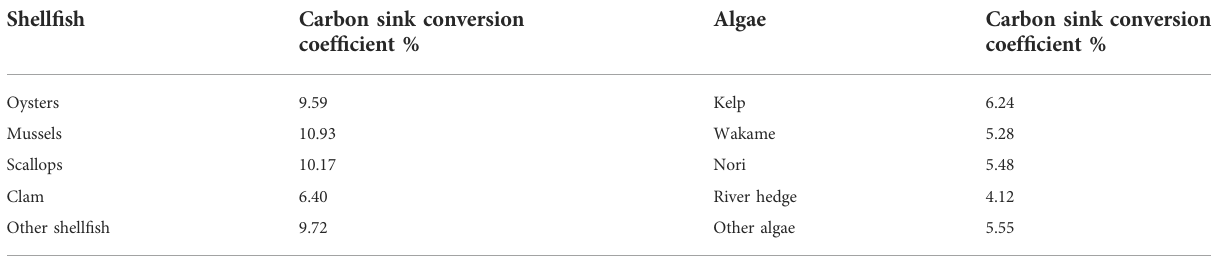
TABLE 1 Carbon sink coef fi cient of shell fi sh and algae.